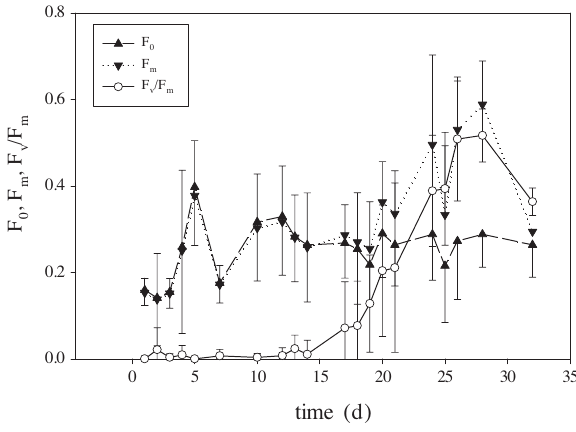
F IG . 1. – Time course of minimal (F (F ) and maximum quantum efficiency (F m Cymodocea nodosa plants grown in high light during a recovery experiment after a four month dark period. Error bars represent